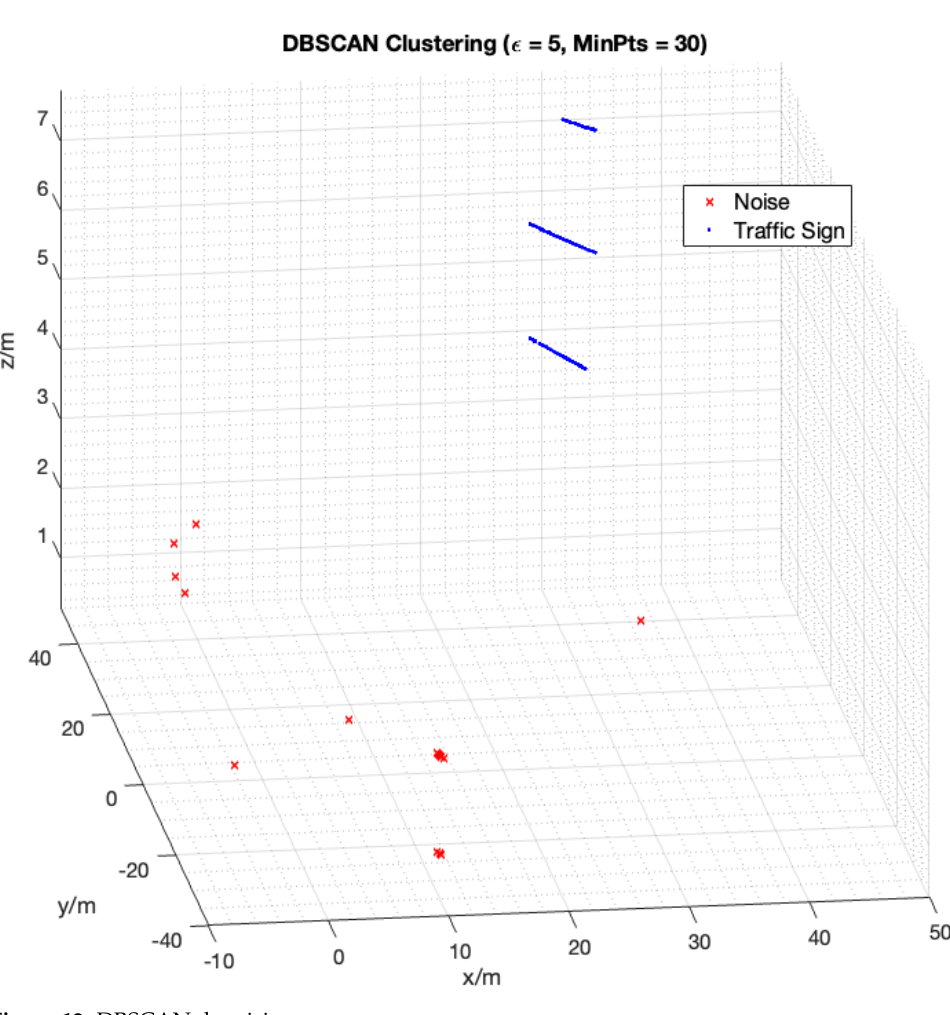
Figure 12. DBSCAN